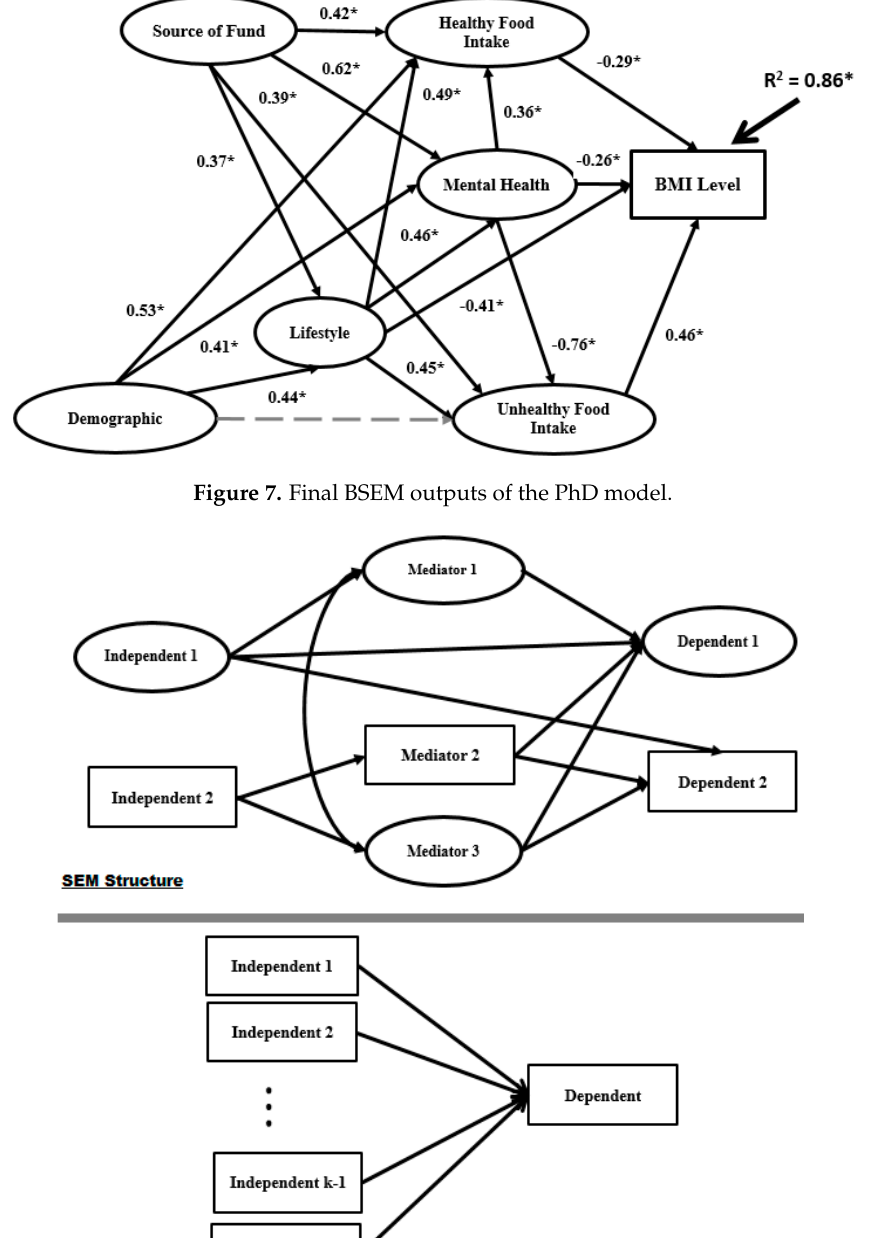
Figure 6. Final BSEM outputs of the Master model.